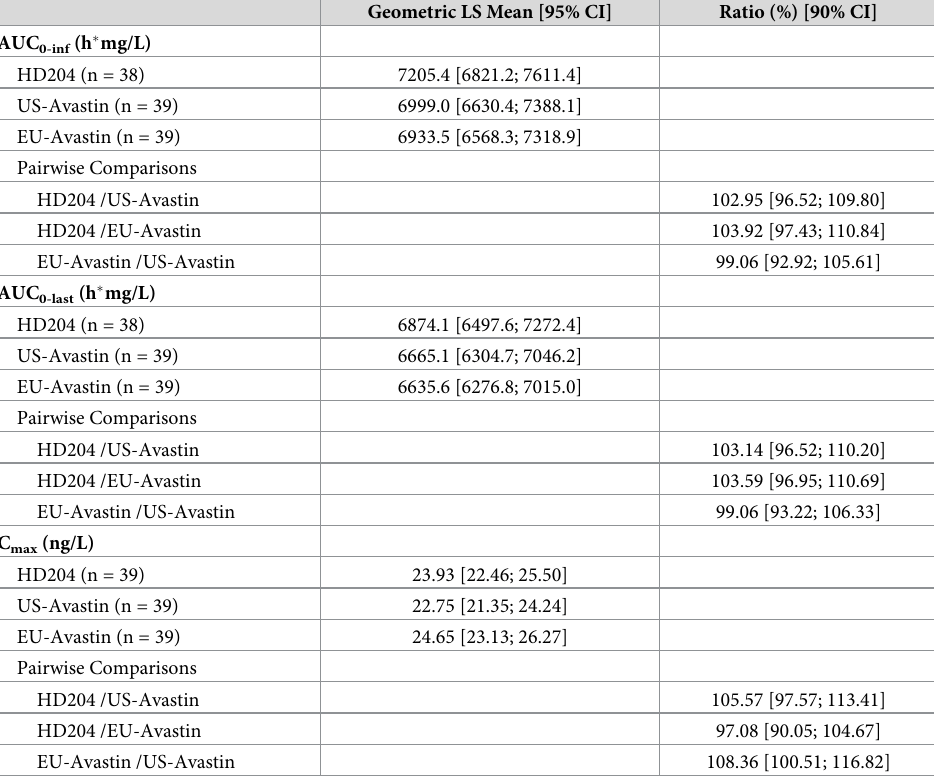
Table 3. Statistical analysis of PK properties of HD204, US-Avastin, and EU-Avastin (PKP